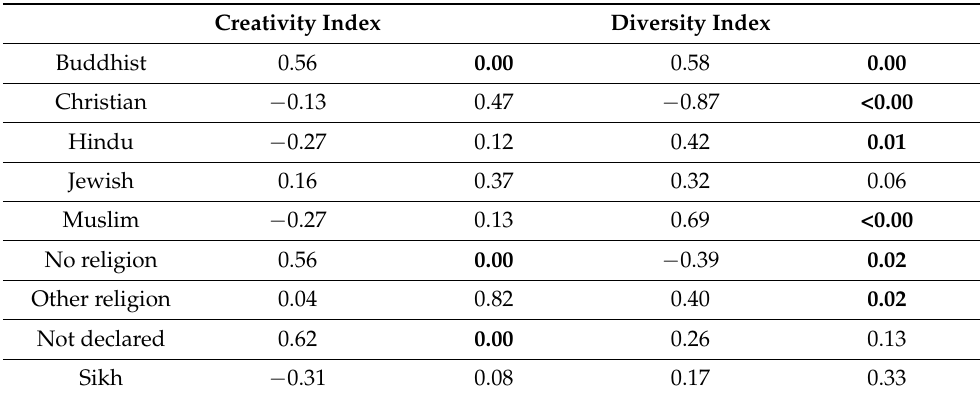
Pearson correlation coefficients between the Diversity and Creativity Indices and professed